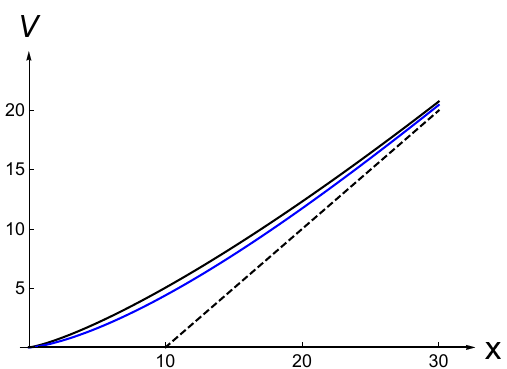
Figure 8. The value of V ( x ) in the case of infinitely many jumps (black) and of single jump (blue line) w.r.t. x . The parameter set is r = δ = 0.03, σ = 0.3, K 1 = 10, K 2 = K 1 ( 1 − γ ) , λ = 0.2, γ = 0.2. The dashed line represents the immediate payoff ( x − K 1 ) +